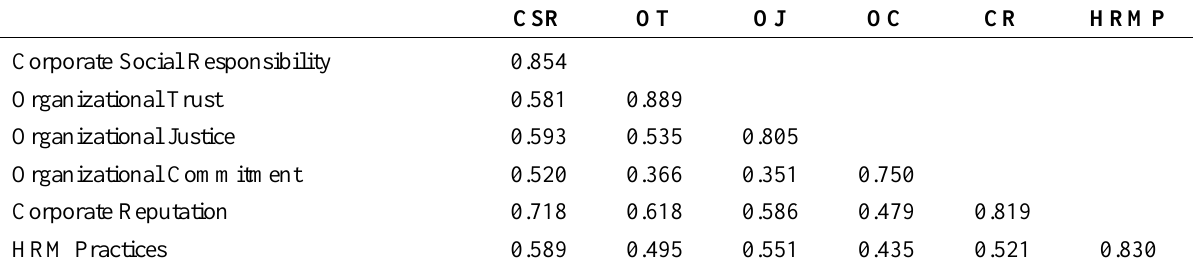
Table.2: Fornell-Larcker Criterion for Discriminant